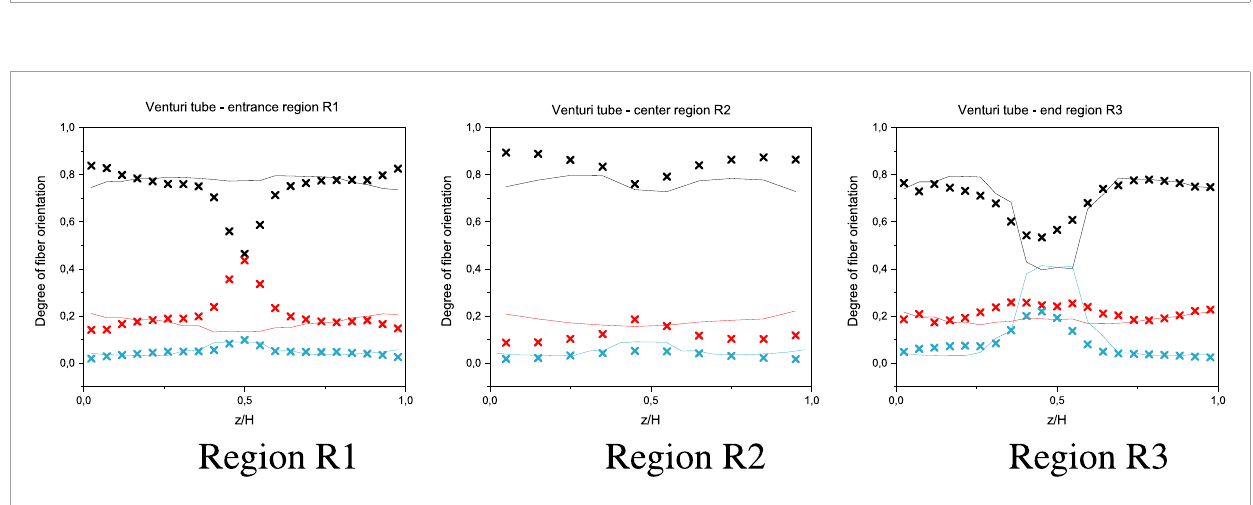
FIGURE 10 Fiber orientation distributions using the IISO-model with 5 parameters with optimization weighted by region (25% R1, 50% R2, 25% R3) X : CT measurements, lines: simulation results, fiber orientation directions: black: xx (in-flow), red: yy (across flow), teal: zz (through-thickness).